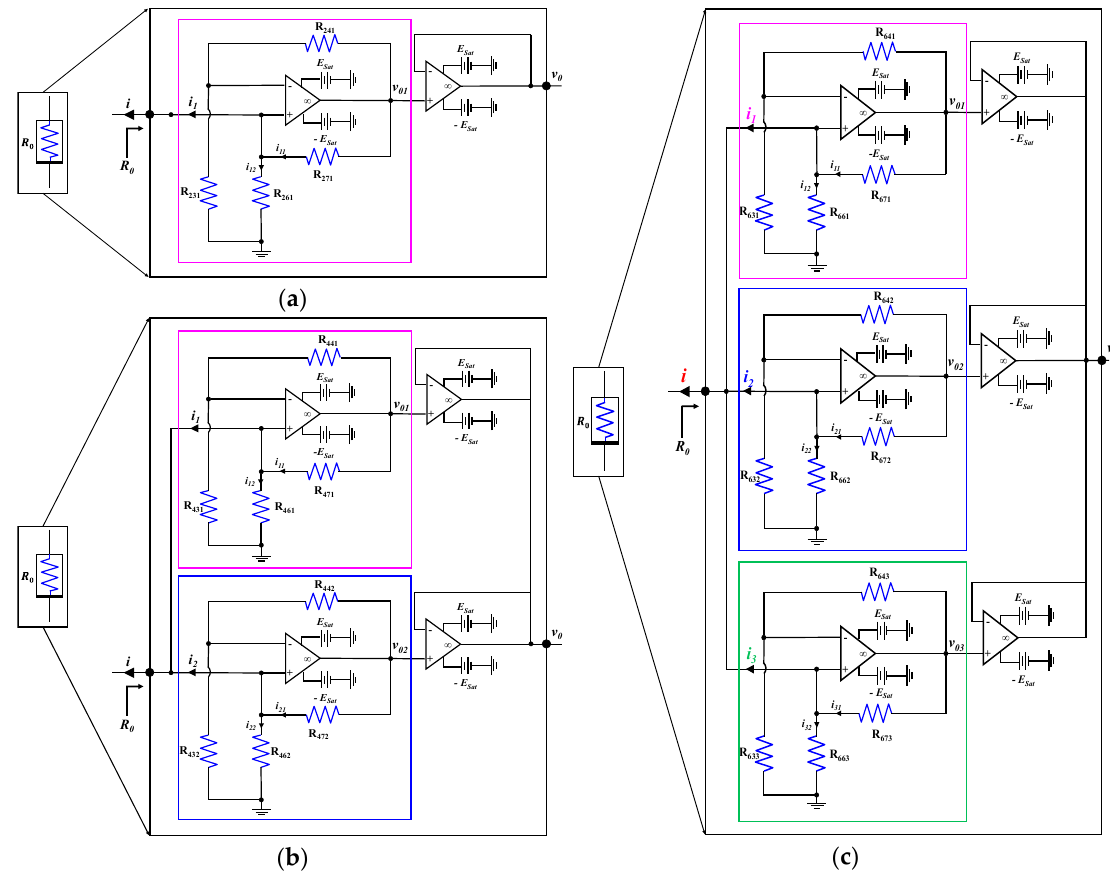
Figure 9. Circuit diagram of the active and locally active nonlinear resistor R 0 for ( a ) 2-lobe CCM , ( b ) 4-lobe CCM, and ( c ) 6-lobe CCM.